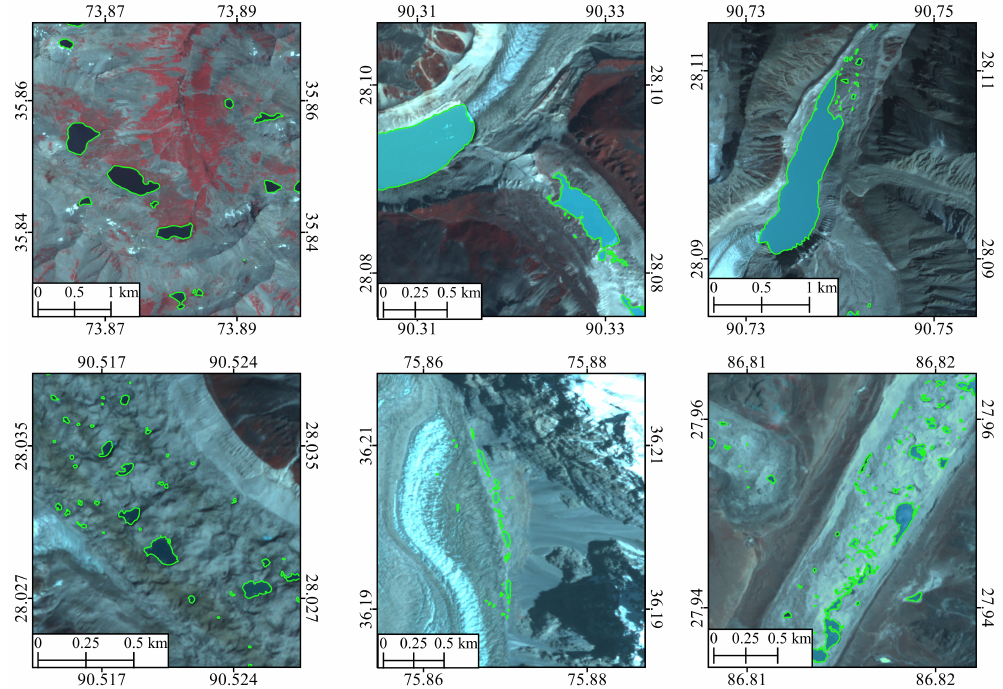
Figure 3. Samples of the digitized lakes (green polygons) shown over the corresponding PlanetScope FCC bands: 4-3-2.